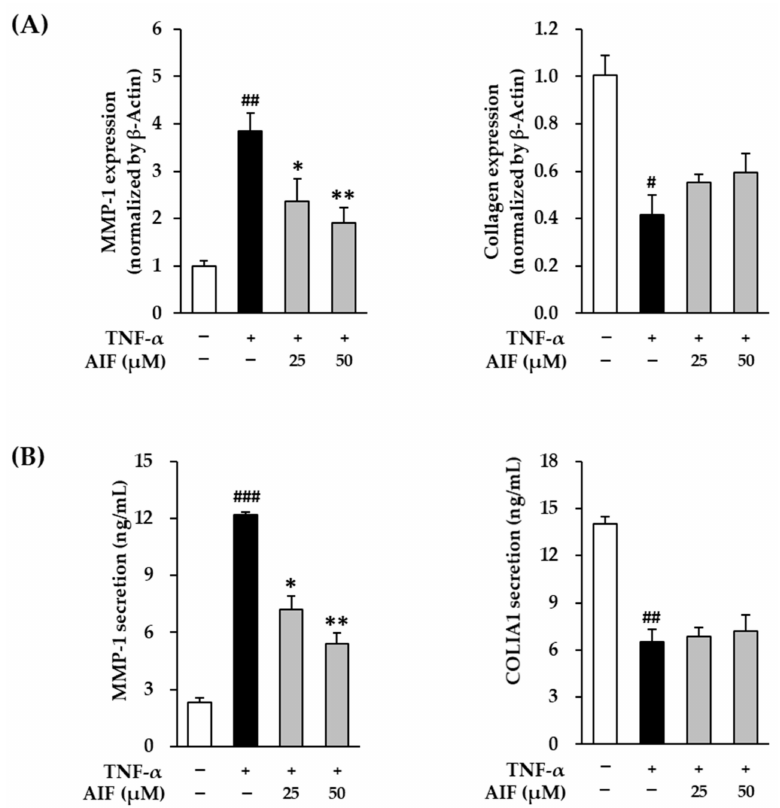
Figure 5. Effect of alpinumisoflavone (AIF) on matrix metalloproteinase-1 (MMP-1) and type I collagen (COLIA1) expression in tumor necrosis factor- α (TNF- α )-treated human dermal fibroblasts (HDFs). ( A ) Relative mRNA expression levels of MMP-1 and COLIA1. ( B ) Secretion of MMP-1 and COLIA1 proteins. HDFs were challenged with 20 ng/mL TNF- α in the presence or absence of AIF (25 and 50 µ M) for 4 or 12 h. The protein expression was determined using qRT-PCR and ELISA. The data are presented as mean ± SEM of at least three independent experiments. # p < 0.05, ## p < 0.01 and ### p < 0.001 as compared with the untreated cells. * p < 0.05 and ** p < 0.01 as compared with the TNF- α -treated